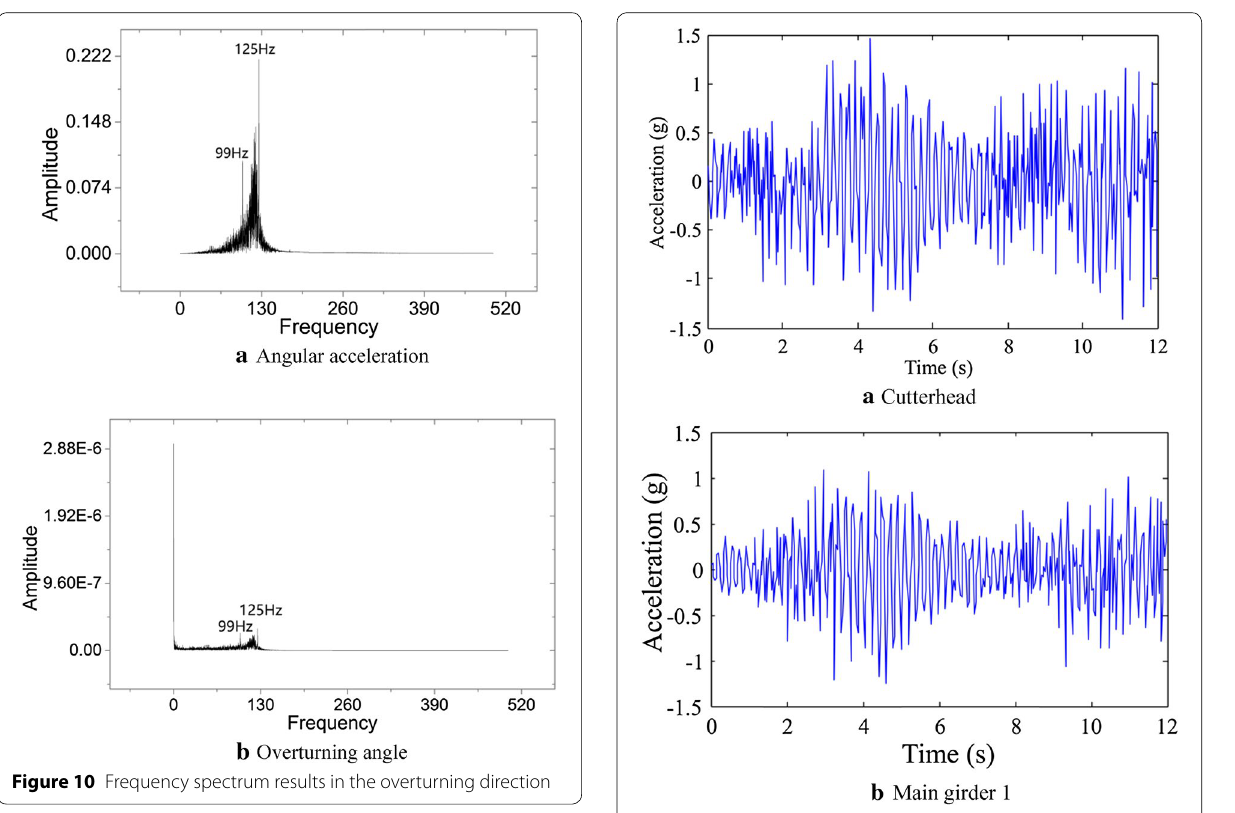
are compared with the theoretical values, as shown in Figure 15. The measured values of the cutterhead lat- eral acceleration are larger than those calculated by the model, which mainly range from 2 g to 2 g . The mean- − + square deviation of the lateral-test acceleration is 1.01 g , whereas the calculated value is 0.61 g . The measured val- ues of the vibration acceleration in the tunneling direc- tion are lower than the calculated values, which mainly range from 3 g to 3 g . The mean-square deviation of − + the measured tunneling acceleration is 1.92 g , and that of the calculated acceleration is 2.1 g .